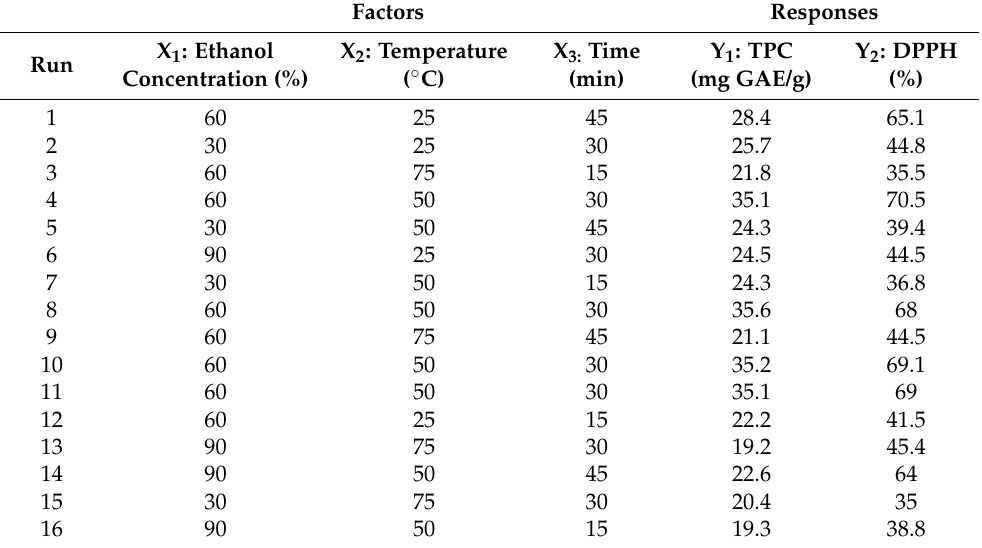
Table 1. Box–Behnken design matrix with coded variables and measured values. Factors